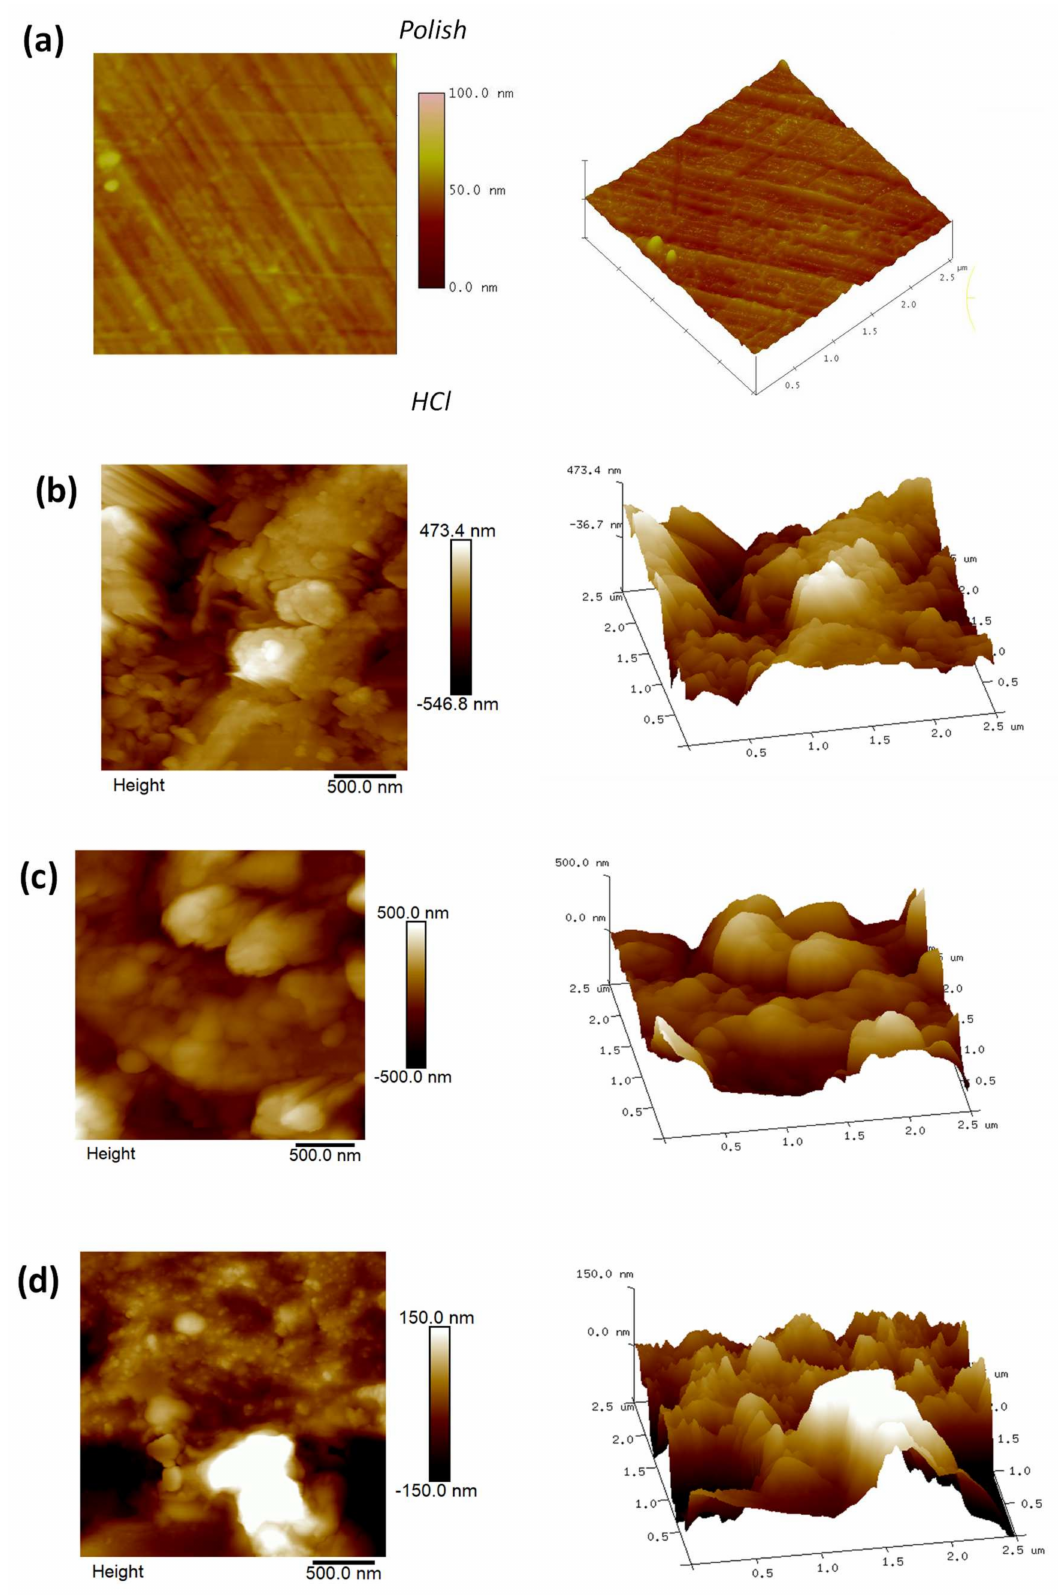
Figure 11. AFM images at different conditions ( a ) polish, ( b ) steel immersed in HCl 1 M, ( c ) inhibitor 3b and ( d ) inhibitor 3f